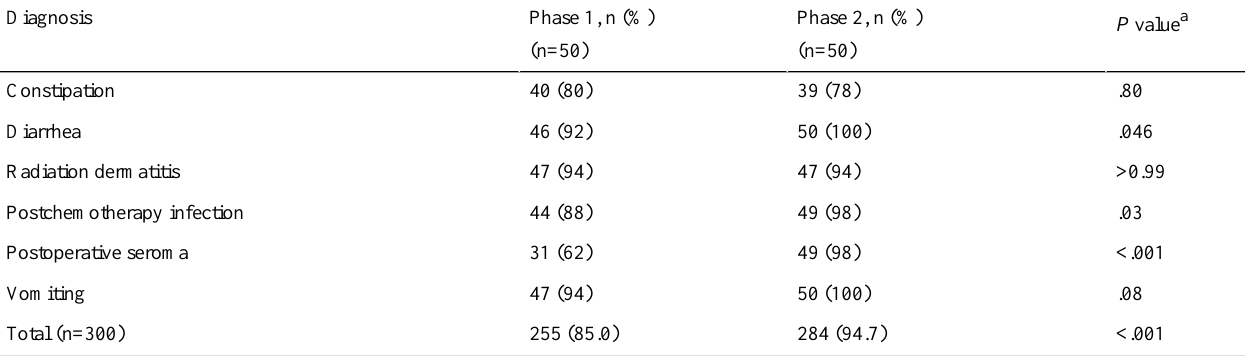
Table 3. Correct diagnosis of cases per phase of study (N=50).